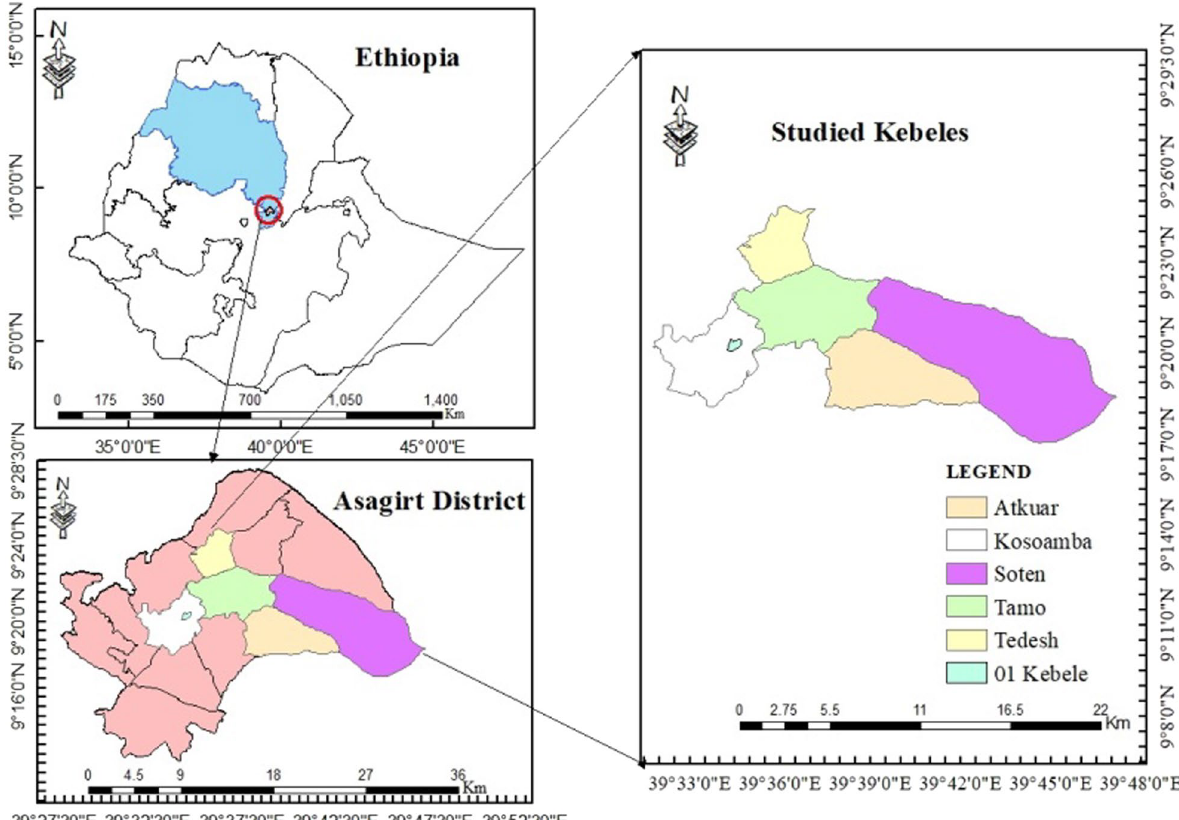
Fig. 1 Map of Asagirt District and sampled kebeles